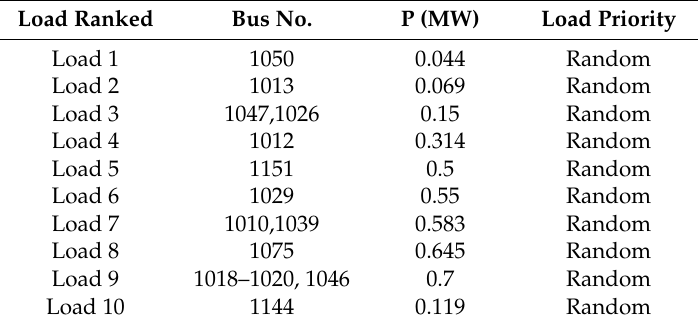
Table 7. Load data and their priority.